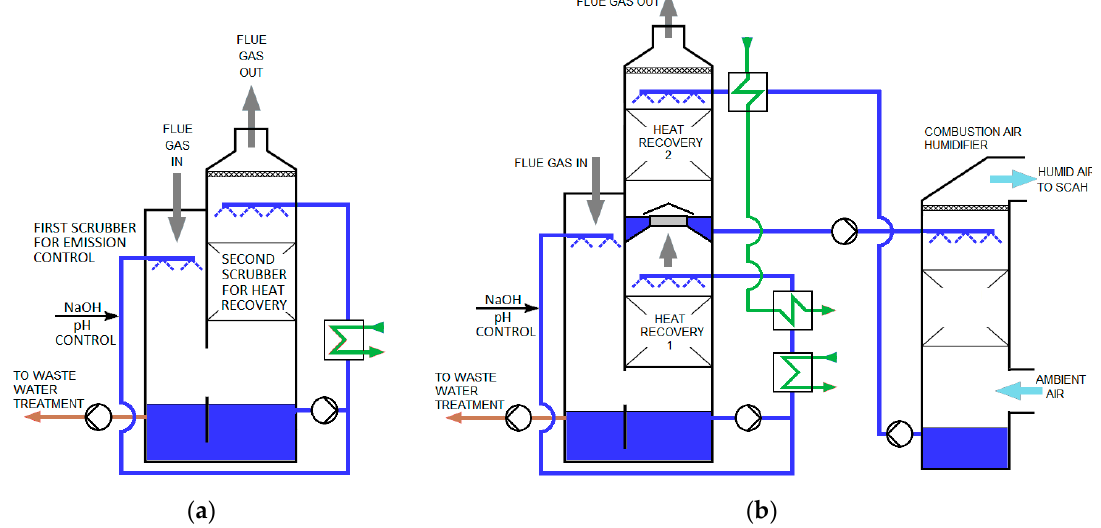
Figure 2. Three considered low-temperature heat recovery spray tower configurations: ( a ) one-stage heat recovery scrubber S1 and ( b ) two-stage heat recovery S2H with combustion air humidification.